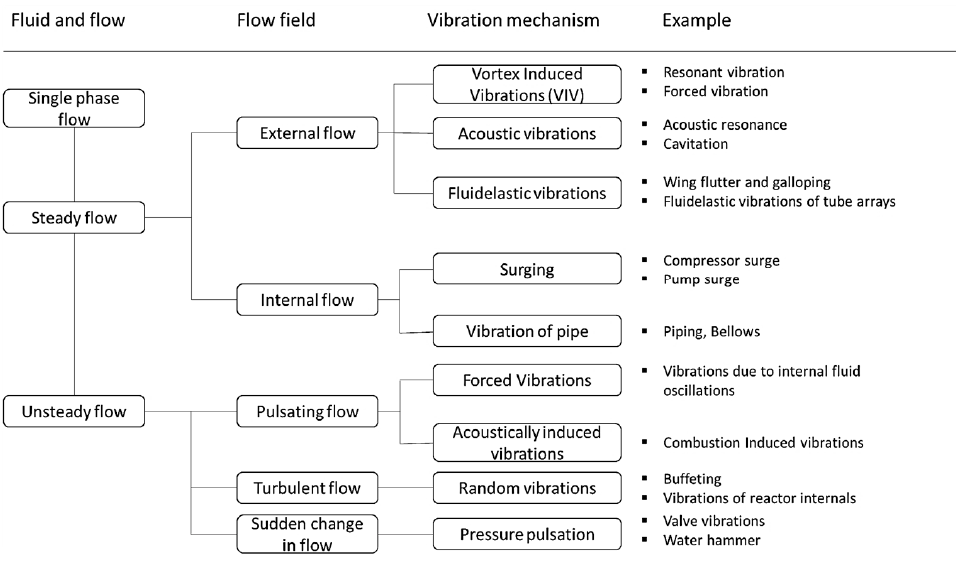
Figure 2. Classification of two-phase flow-induced vibrations.